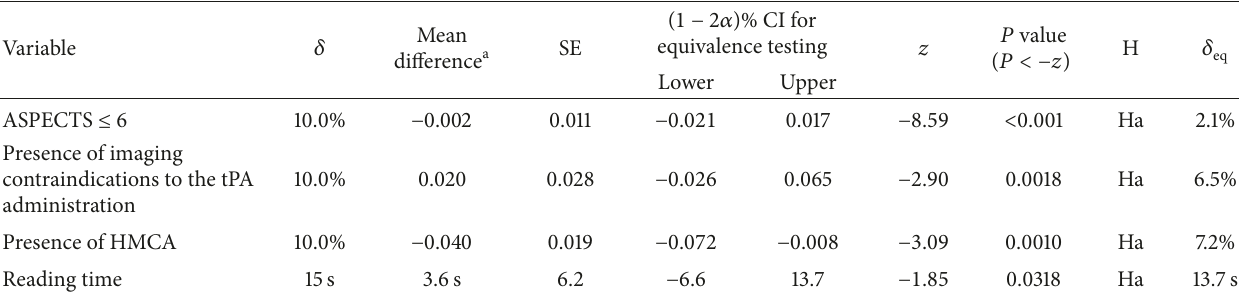
Table 4: Equivalence tests for the diagnostic variables and reading